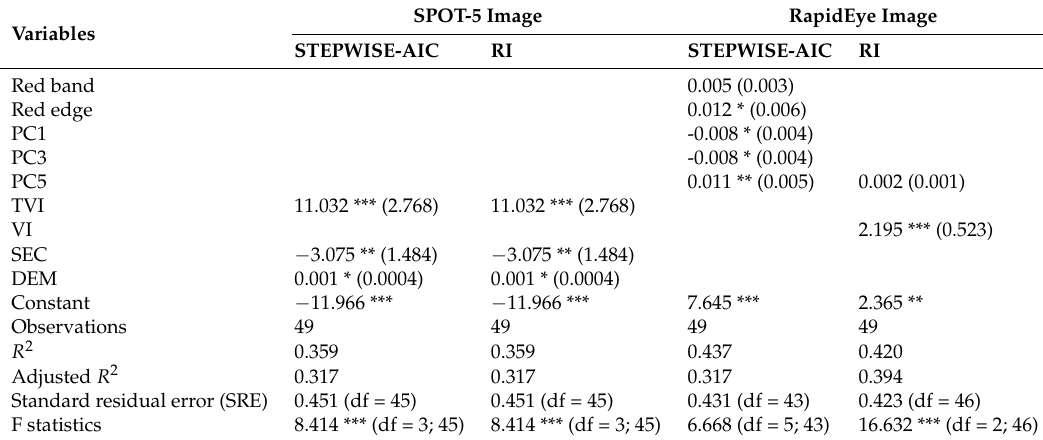
Table 5. Variables selected from both SPOT-5 and RapidEye images by STEPWISE-Akaike information criterion (AIC) and relative importance (RI) approaches for AGB regression models. Variables